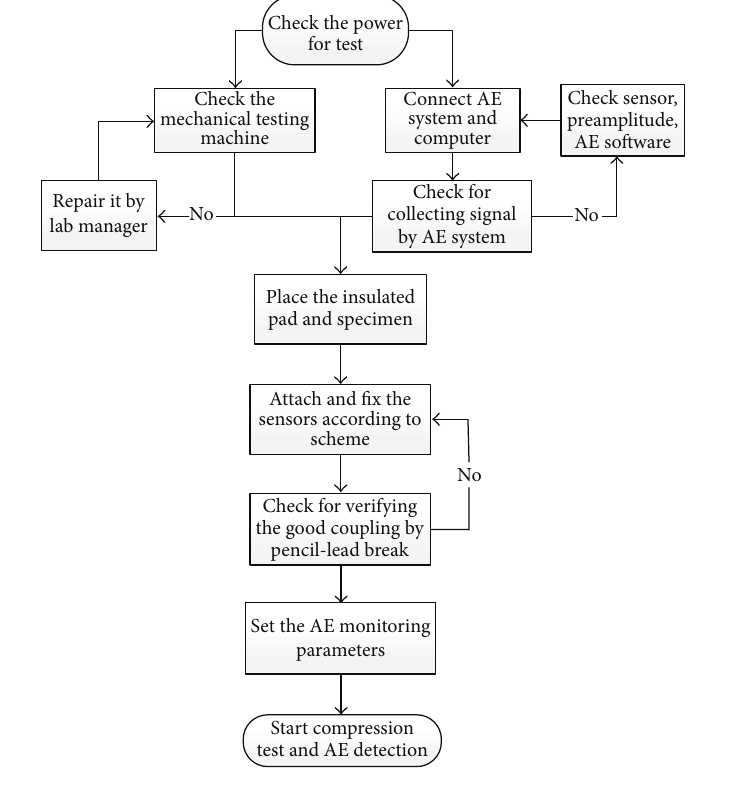
Figure 5: AE test process.